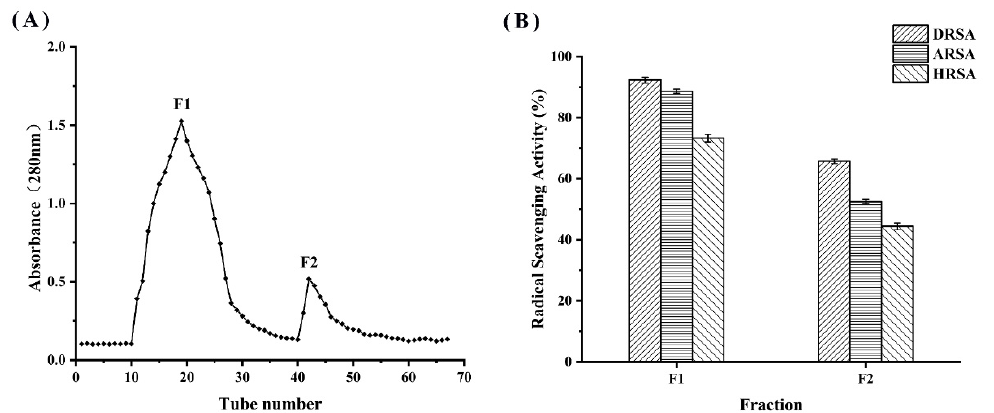
Figure 7. ( A ) Filtration chromatography by DEAE cellulose-52 and ( B ) determination of the antioxi- dant activity of the F2 fraction.